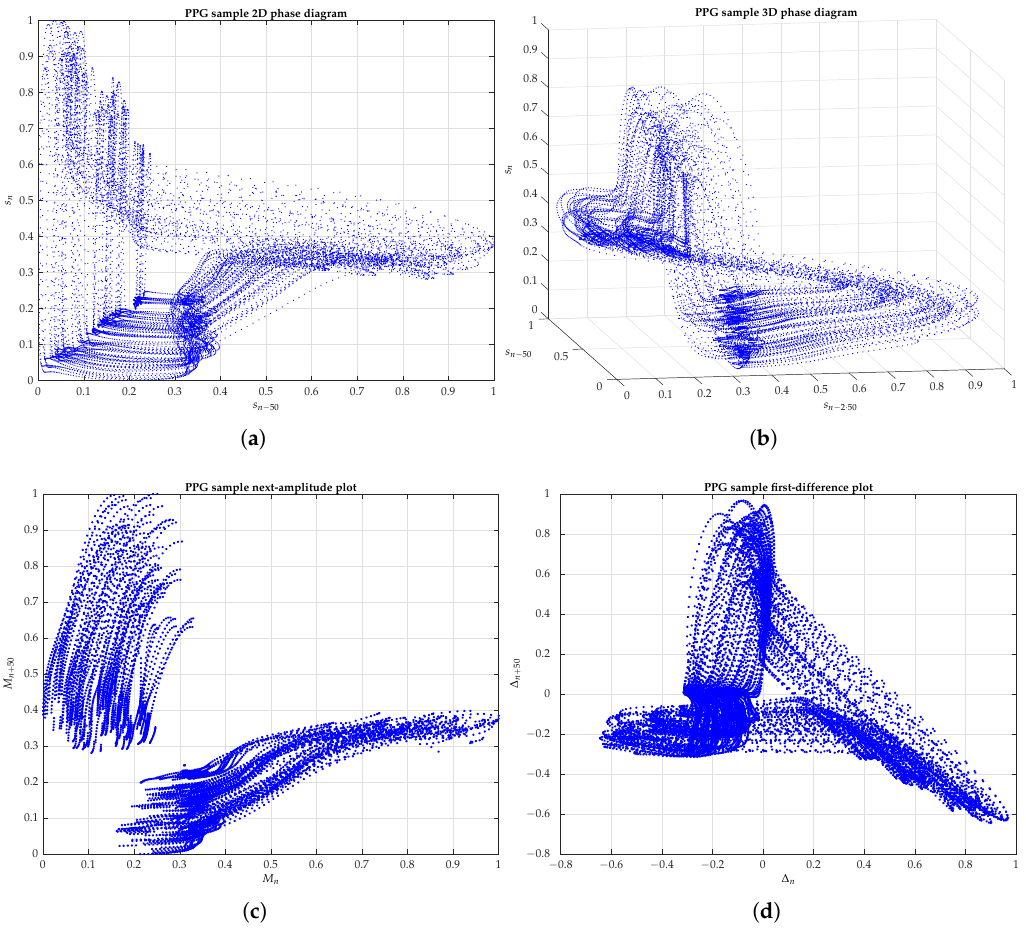
Figure A3. From a sample PPG signal and for τ = 50: ( a ) 2D phase diagram; ( b ) 3D phase diagram; ( c ) successive-maxima plot; ( d ) difference